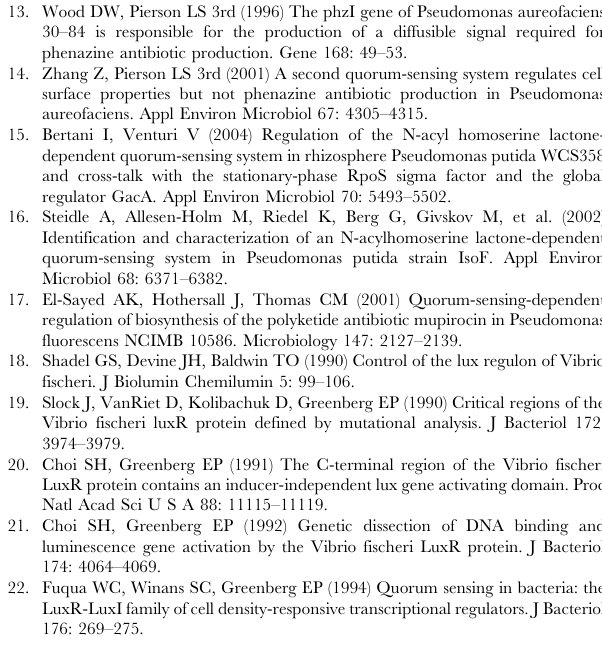
Figure S1 Lipase secretion in LB Agar-tributyrin plate assay. Figure showing lipase secretion phenotype on LB Agar-tributyrin